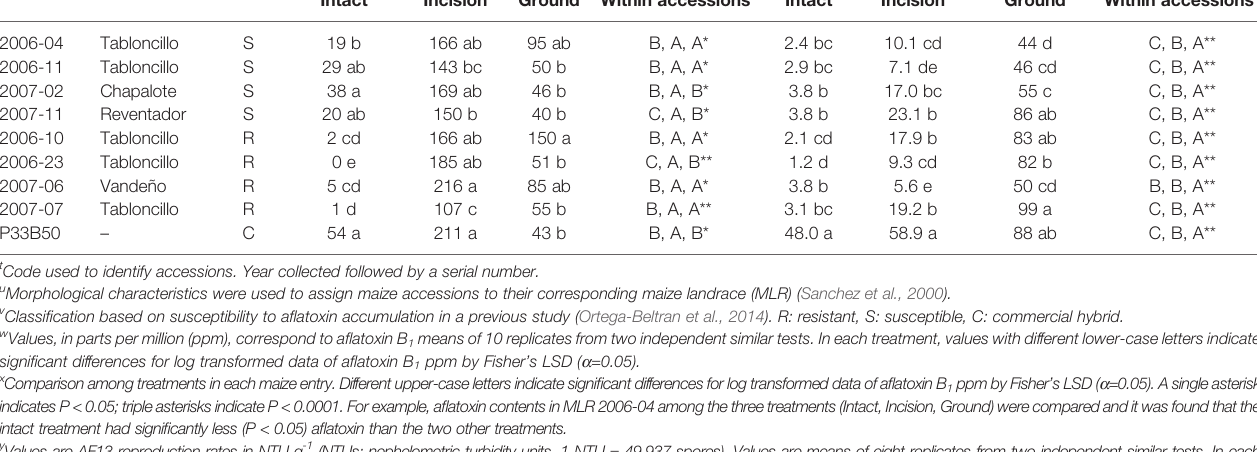
differences among kernels with compromised tissue integrity ( Table 2 ). Ground kernels supported the lowest a fl atoxin content (64 ppm). Bisected kernels accumulated a fl atoxin levels similar to those accumulated by kernels subjected to each pin-wounded treatment, but signi fi cantly ( P < 0.0001) less than kernels with an incision ( Table 2 ). Signi fi cantly ( P < 0.0001) lower fungal reproduction occurred in intact kernels, as expected, than in other treatments ( Table 2 ). The greatest fungal reproduction occurred in ground kernels, but this treatment yielded the least a fl atoxin content ( Table 2 ). No signi fi cant differences in fungal growth were detected among kernels with any of the four types of incision in the embryonic region.